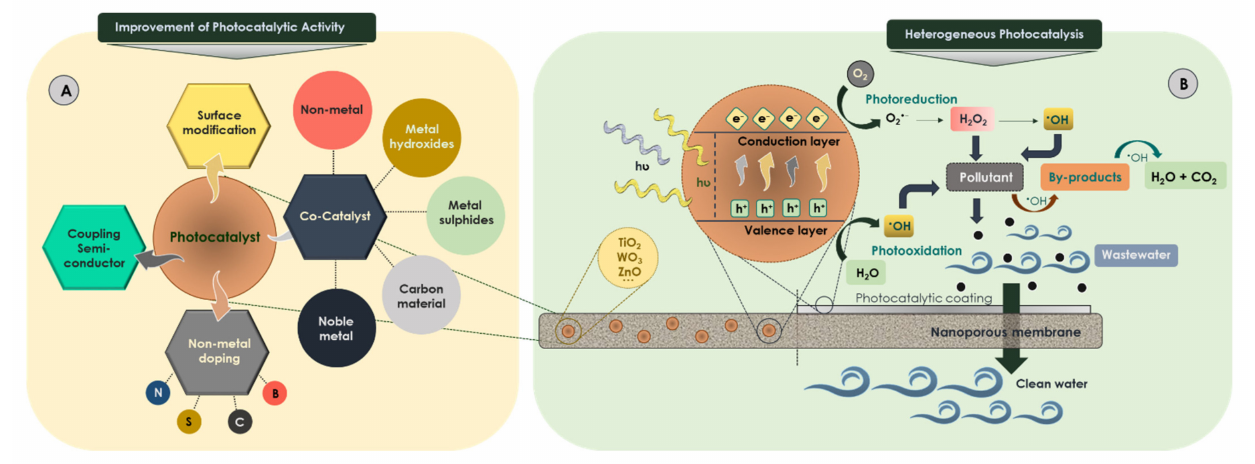
Figure 4. ( A ) Improvement of photocatalyst and ( B ) heterogeneous membrane